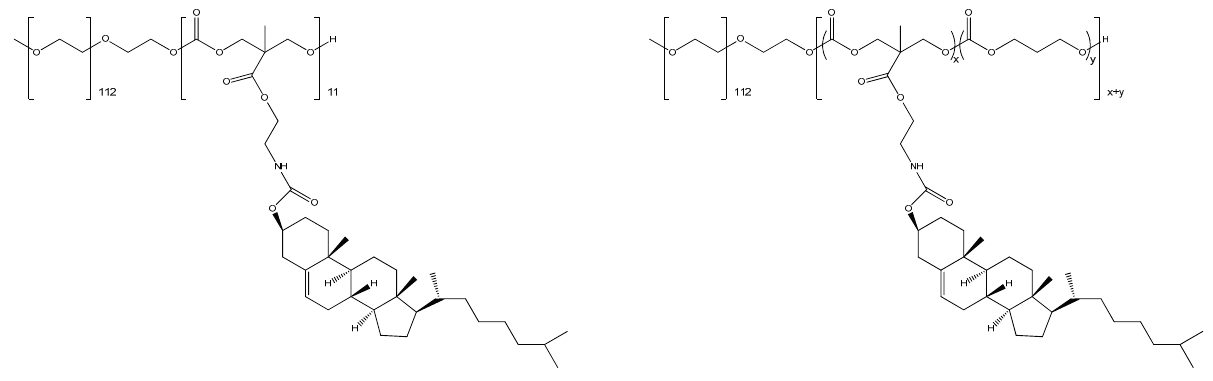
Figure 9. Structures of some biodegradable and amphophilic co-polymers with Cholesterol as functionalization to target tumor cells. See the text and Lee et al. [88] for